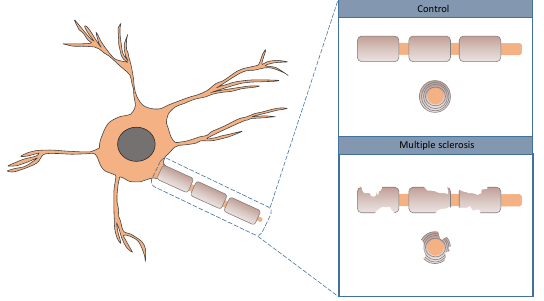
Figure 1. Graphical illustration of neurological damage in